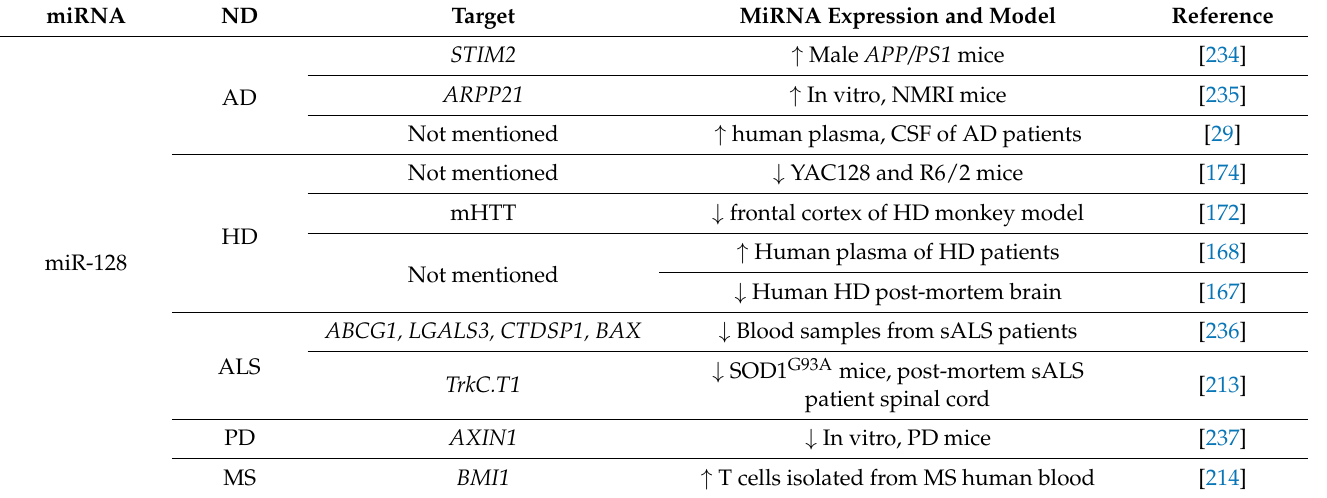
Table 7. Summary of miRNA dysregulation across